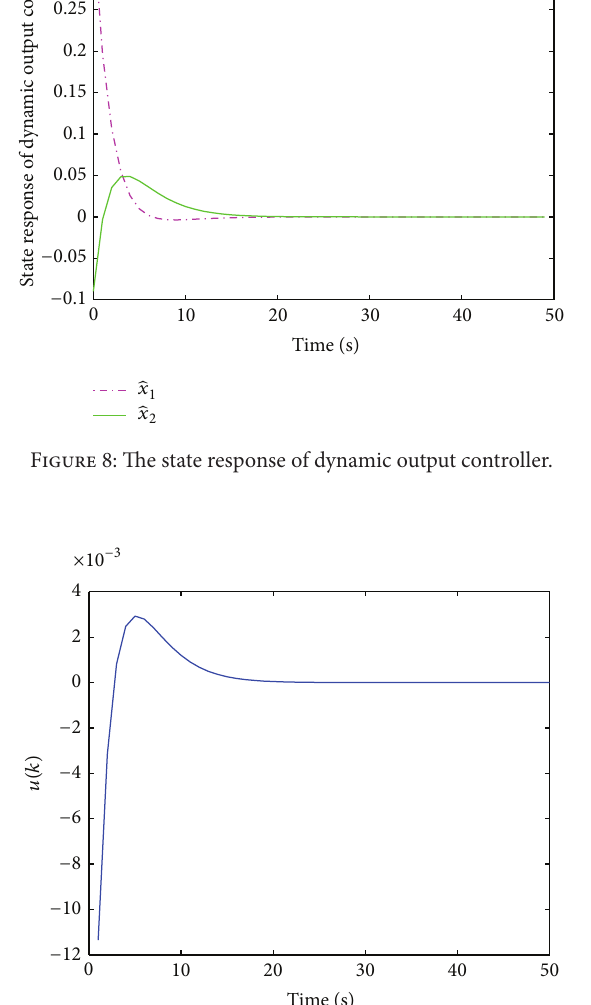
Figure 11: The output of closed-loop